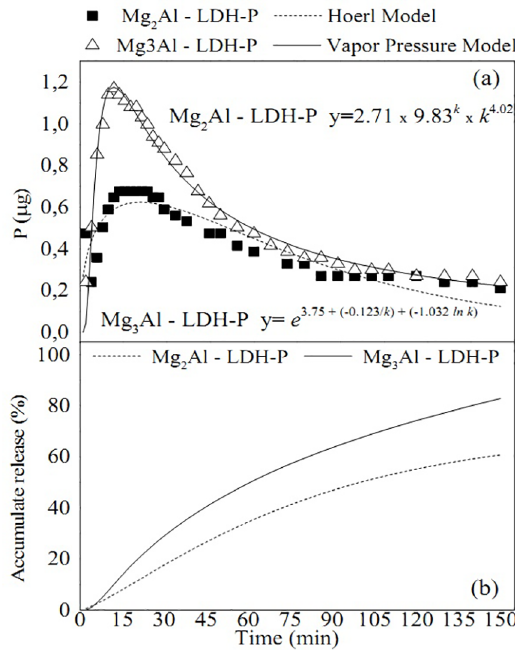
Al-LDH-P and Mg Al-LDH-P 2 3